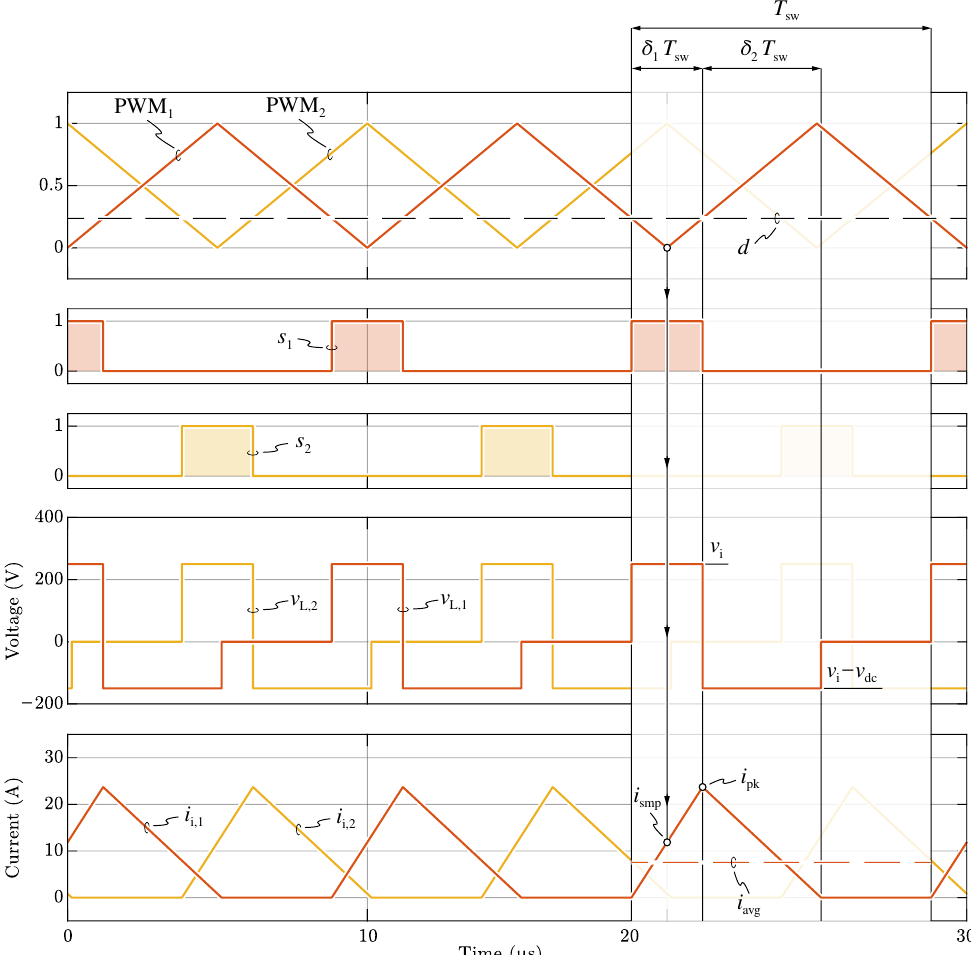
Figure 3. Basic waveforms of the interleaved dual-boost PFC operated in DCM, considering L i = 25µH, f sw = 100kHz, v i = 250V, v dc = 400V and i i = 15A (refer to Figure 2 for nomencla- ture). The difference between average current ( i avg ), peak current ( i pk ) and sampled current ( i smp ) is